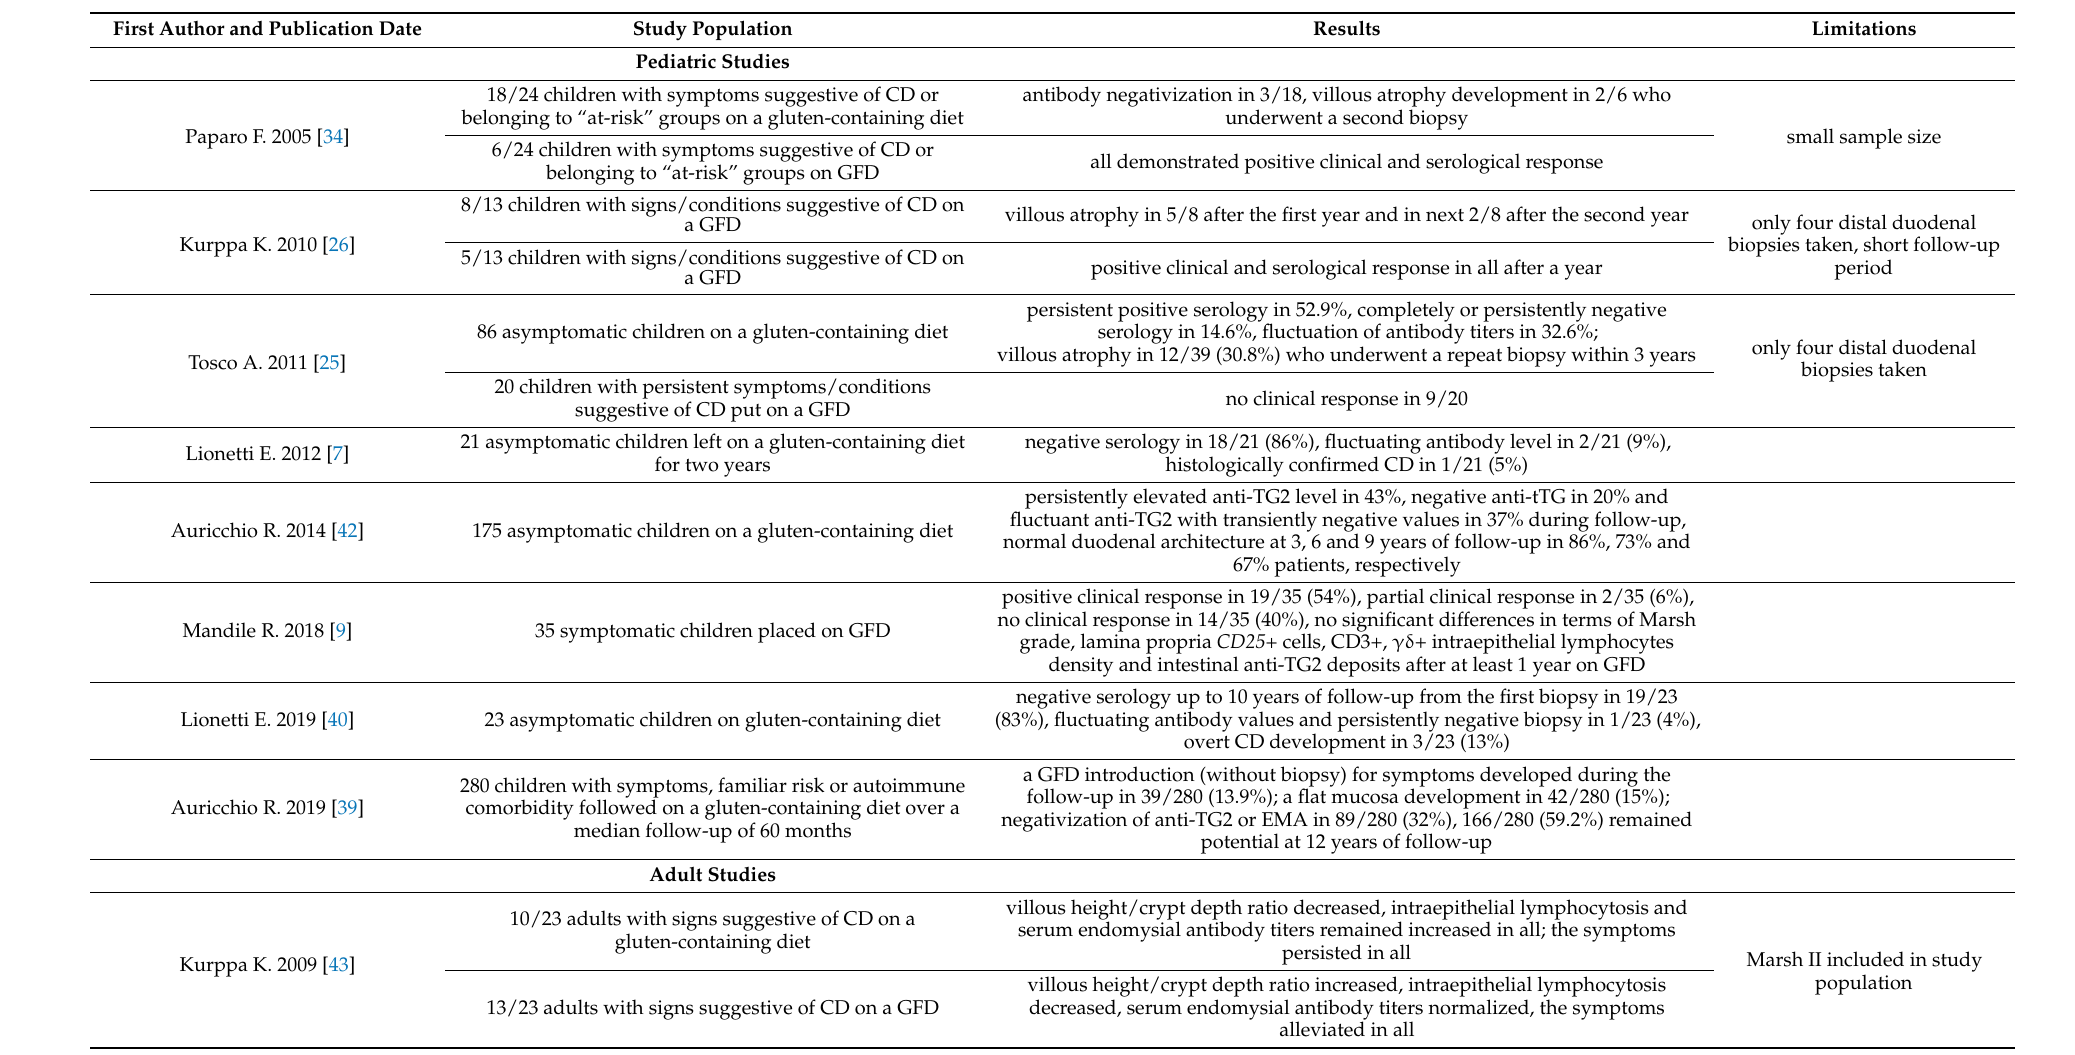
Table 1. Results of available evidence of a different dietary approach for potential coeliac